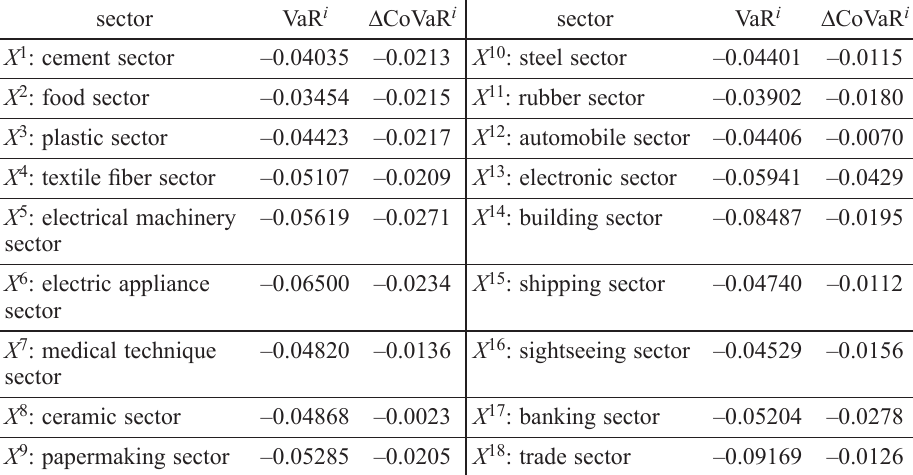
Table 5. Yearly pairs of VaR i and  CoVaR i for 18 sectors